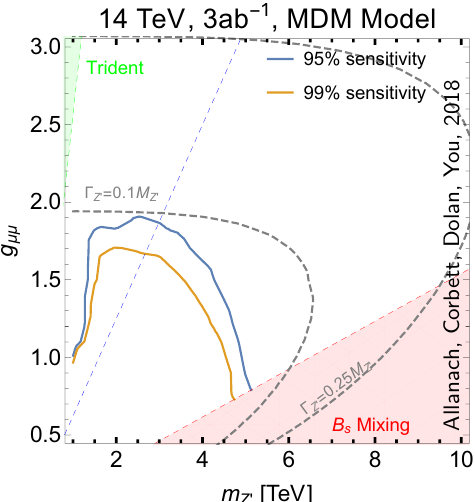
Figure 8 . Predicted sensitivity for the MDM model with the 14 TeV LHC with 3/ab integrated luminosity in the M Z 0 { g (cid:22)(cid:22) plane. Each point in the plane (cid:12)ts the neutral current B -anomalies, since eq. (2.2) with x = 1 : 00 has been enforced meaning that g bs / M 2 =g (cid:22)(cid:22) . The solid lines show Z 0 the regions of 95% CL and 99% CL sensitivity being below each contour. We show only the MDM model, since the HL-LHC does not have sensitivity to the allowed MUM parameter space. In order to show more of the parameter space, we have displayed the pre-2016 B s mixing constraint in pink and the one based on eq. (2.3), where the region below the blue dashed line is ruled out. The grey dashed lines show the values of the relative decay width (cid:0) Z 0 =M Z 0